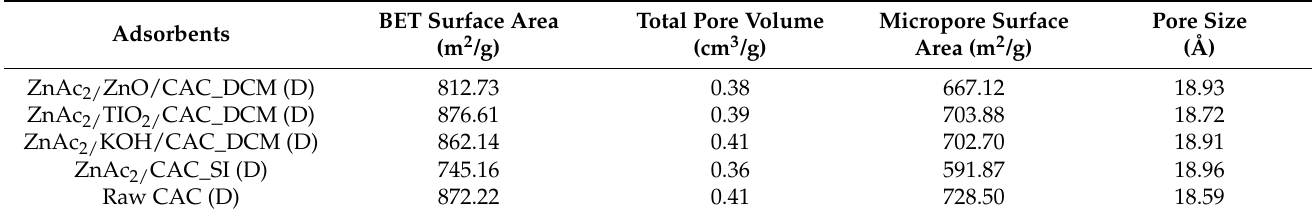
Table 7. Porous properties for exhausted DCM/CAC, SI/CAC, and raw CAC adsorbents.